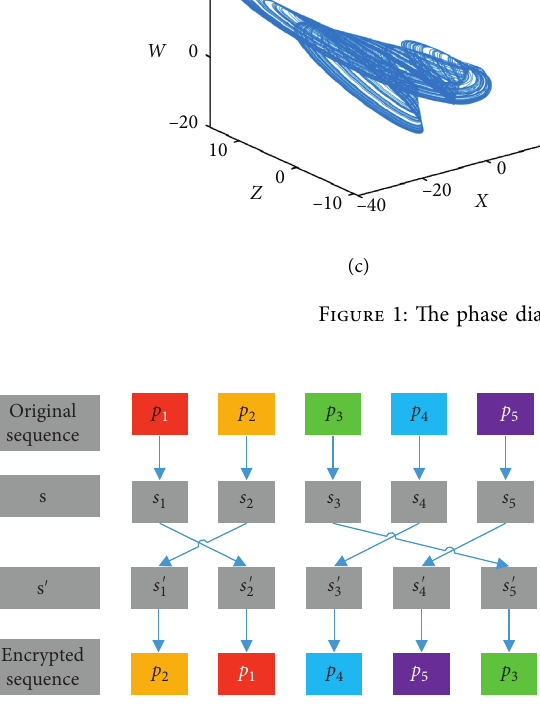
Figure 2: The flowchart of the scrambling process.